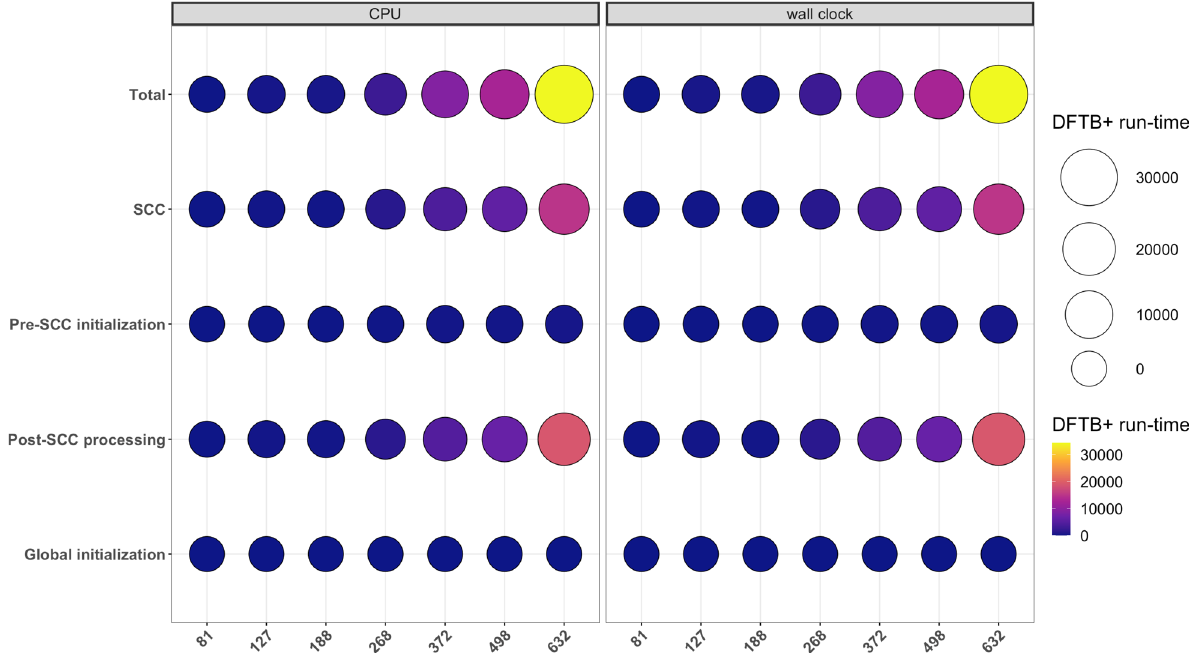
Figure 2. Run-time (seconds) rate of DFTB+ computation as the number of atoms increase. The abscissa show atom numbers and ordinate task names in DFTB+. SCC = diagonalization + density matrix creation, post-SCC processing: eigenvector uniting + energy-density matrix creation + force calculation. The figure is made using ggplot2, ggpubr, dplyr and reshape2 packages in R